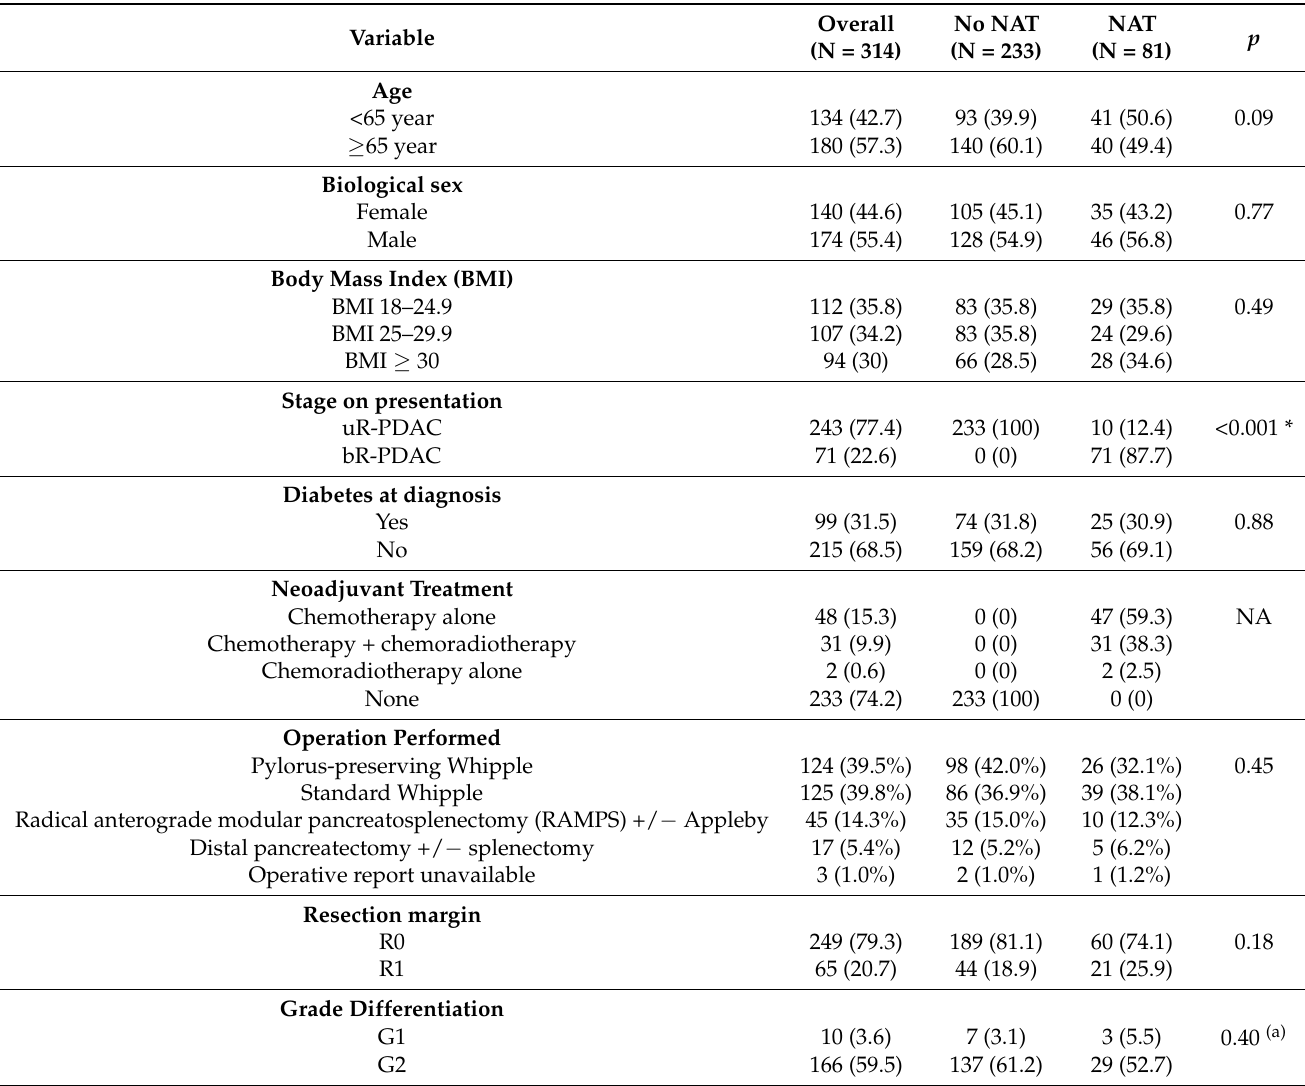
Table 1. Comparison of patient characteristics between those who received NAT and those who did